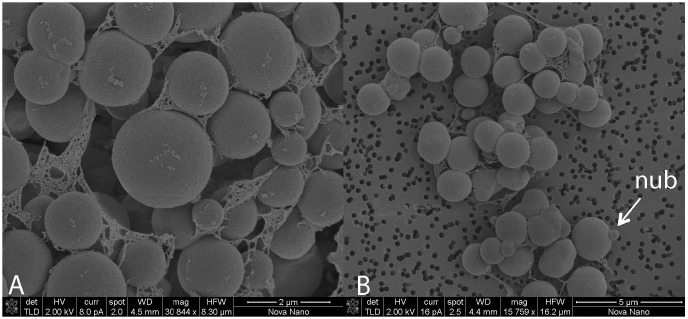
Transmission electron microscopy (TEM) micrographs of cell aggregates of strain RSK. (A) Magnification 30844 x, (B) Magnification 15759 x.